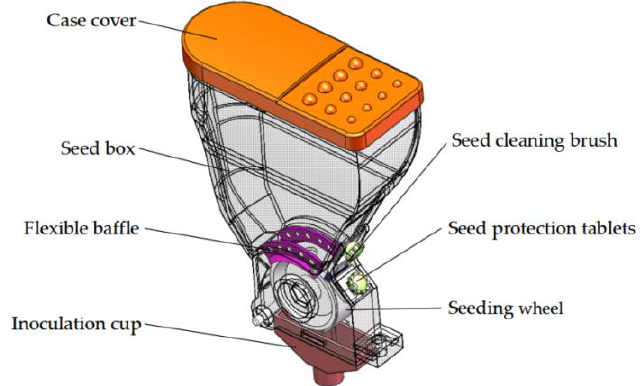
Figure 2. Type hole wheel seed metering device.